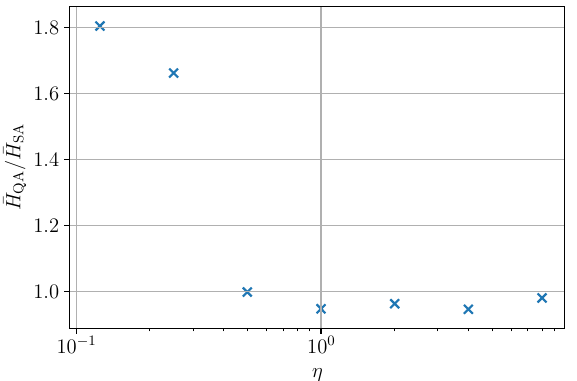
Figure 8. The time averaged values of the Hamiltonian for the simulated annealing ( ¯ H SA ) and the quantum annealing ( ¯ H QA ) as a function of η . Parameters α and L are fixed as α = 0.8 and L = 50